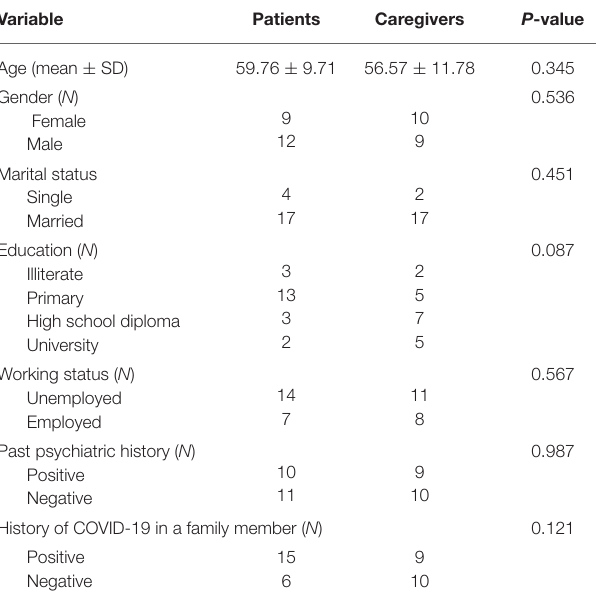
TABLE 3 | Impact of event scores in patients and caregivers.